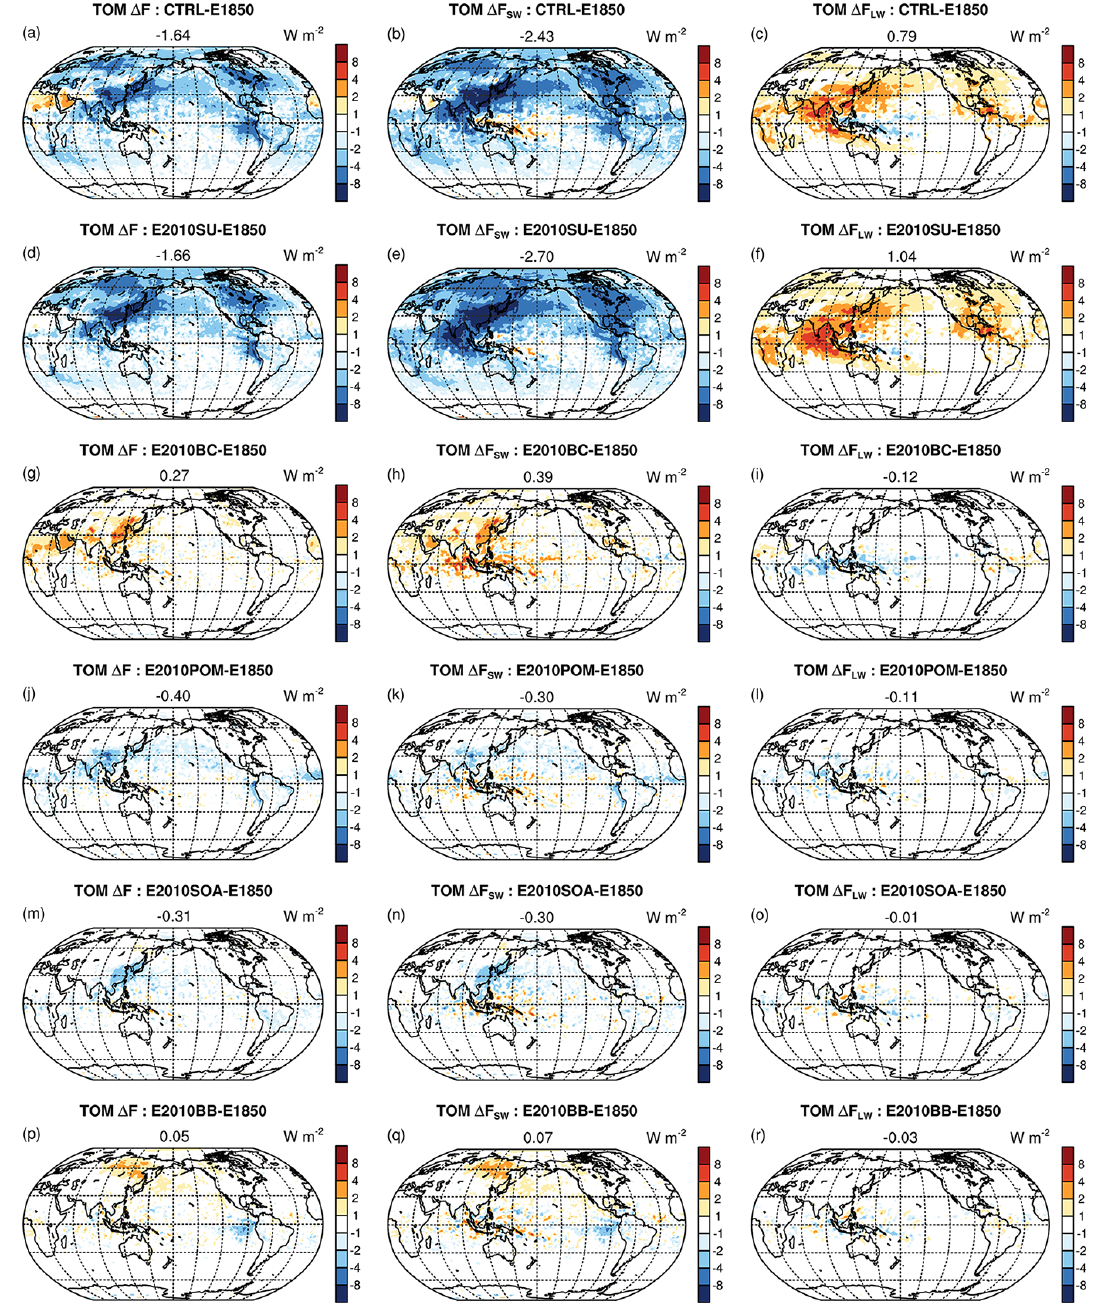
Figure 15. Geographical distributions of the annual mean net (left column), shortwave (middle column), and longwave (right column) top- of-model (TOM) effective radiative forcing by individual aerosol components (i.e., compositions). For example, “E2010SU” indicates the same simulation as E1850 but with present-day (2010) sulfur emissions. See Sect. 5.2 and Table 1 for